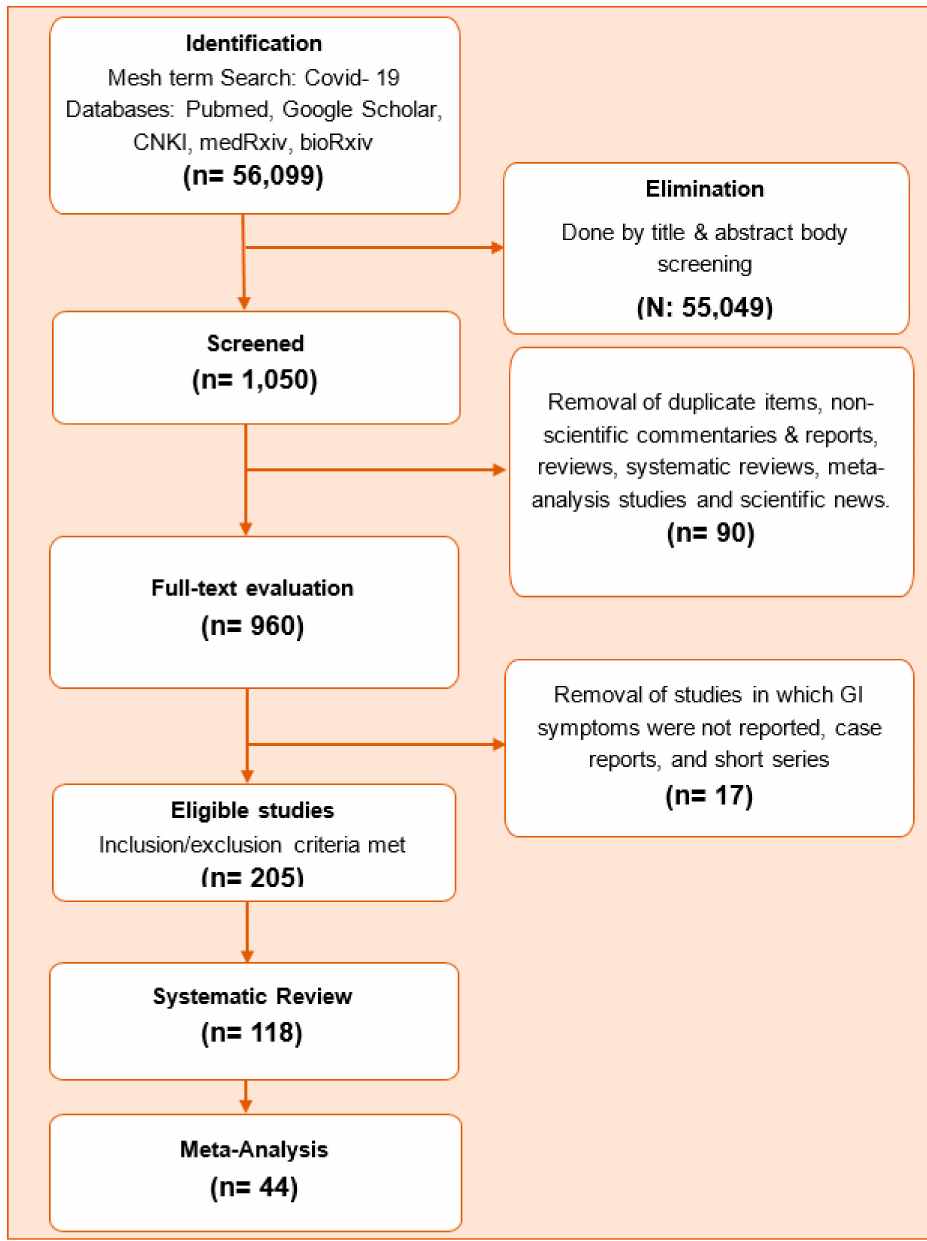
Figure 1. Study flow